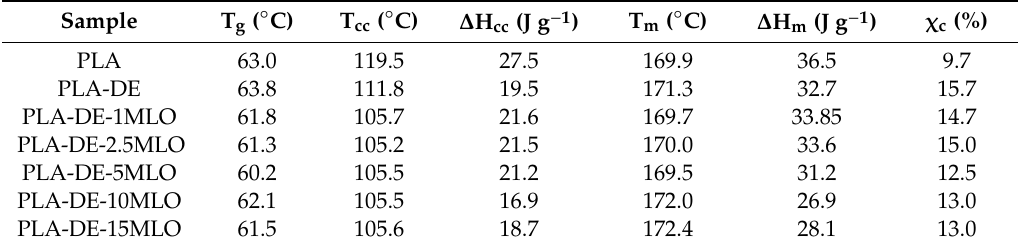
Figure 2. DSC thermograms of neat PLA and PLA+DE composites with different MLO loading Figure 3. DSC thermograms of neat PLA and PLA + DE composites with di ff erent MLO loading (expressed in phr). (expressed in phr). Table 3. Main thermal parameters of PLA and PLA+DE composites with different MLO loading Table 3. Main thermal parameters of PLA and PLA + DE composites with di ff erent MLO loading (expressed in phr) obtained by differential scanning calorimetry (DSC). (expressed in phr) obtained by di ff erential scanning calorimetry